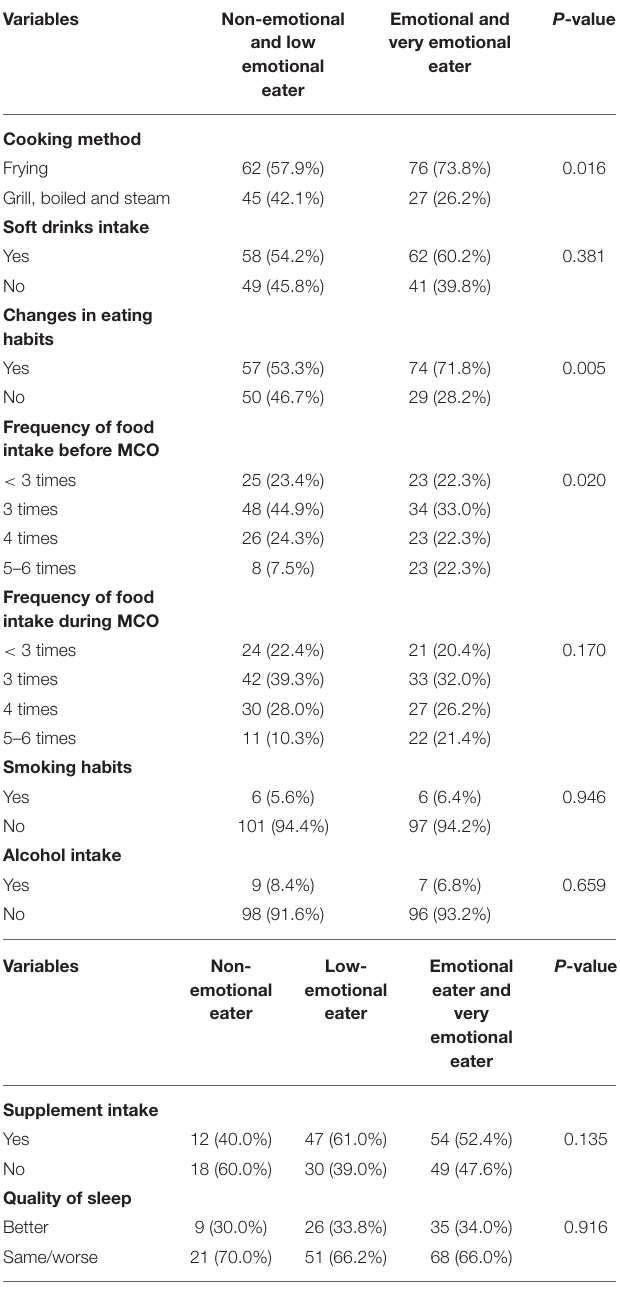
TABLE 4 | Association between psychological factors affecting eating habits and level of emotional eater (EEQ).